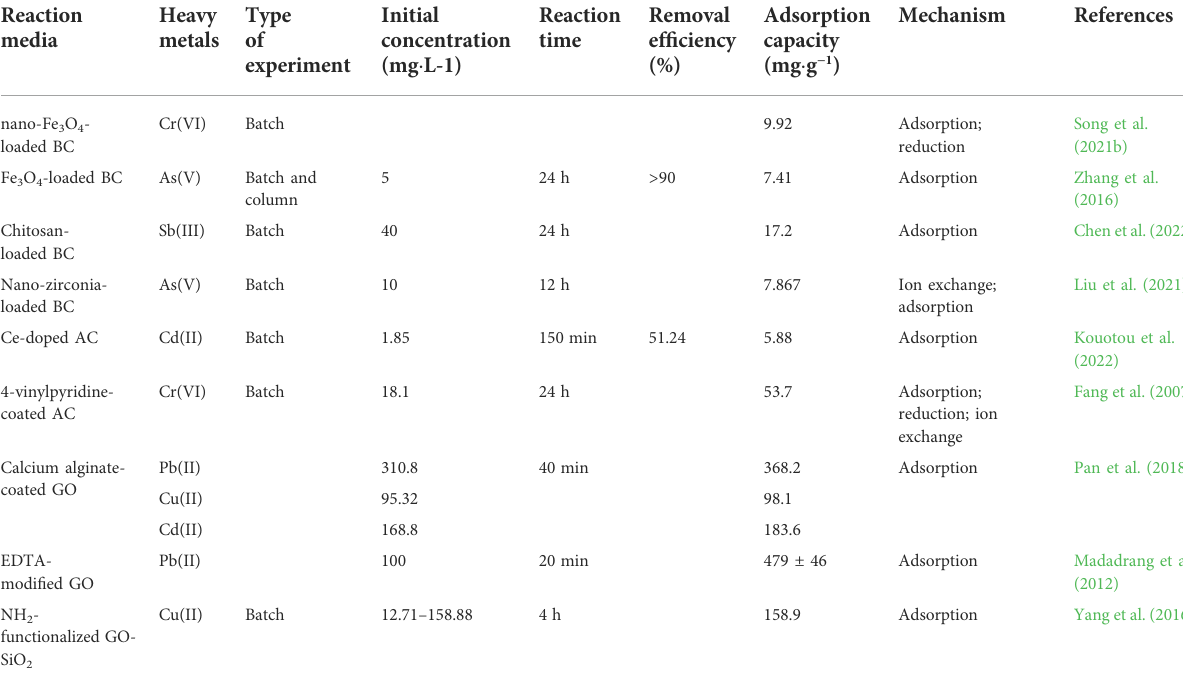
TABLE 7 Application of carbon-related composite materials in PRB treatment of groundwater heavy metals. Reaction